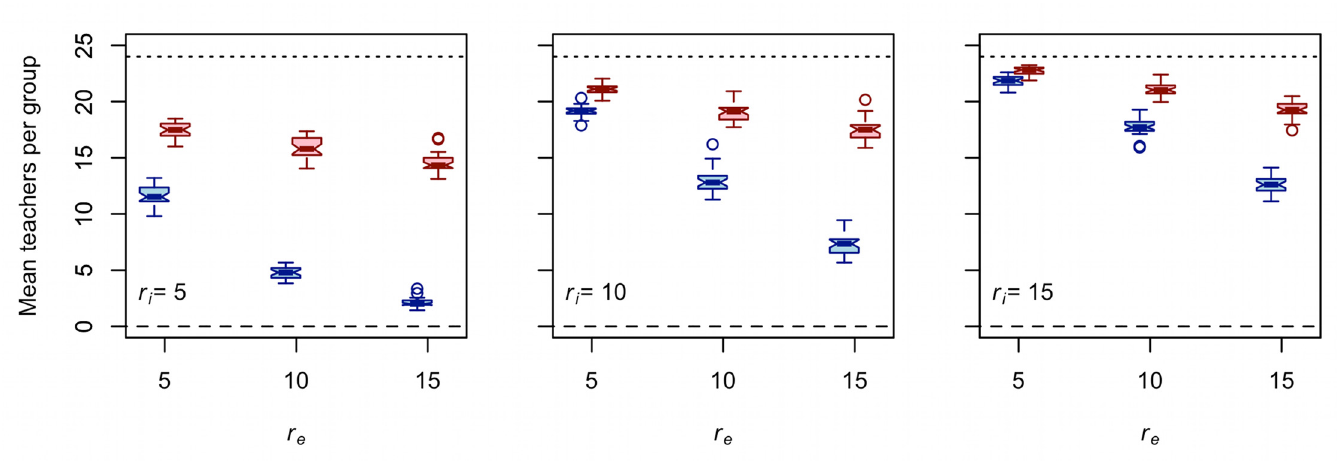
Fig 4. Increasing r e decreases the mean number of teachers per group for both trait A (blue) and trait B (red). Each boxplot represents 30 unique simulation runs. The length of the interaction radius increases from the left panel to the right panel. The dotted line provides the expected value in an idealized Wright-Fisher population. The dashed line provides the expected value under extreme uniparental vertical cultural transmission. Note that d = 0.75 and that these results are exactly the same for all values of μ